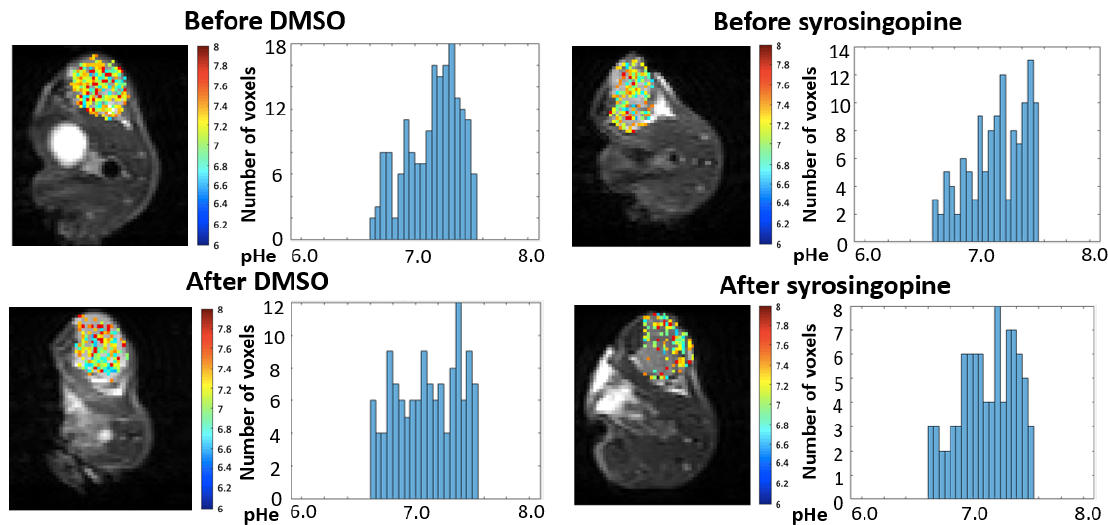
Figure 5. Impact of syrosingopine on tumor pHe . The evolution of pHe was evaluated using CEST- MRI in MDA-MB-231 tumor xenografts. Typical images and histograms of distribution of pHe values recorded before and after vehicle administration ( left ), and before and after syrosingopine administration ( right ) (daily IP injection over 4 days, 5 mg/kg). Images were acquired from the same mice.